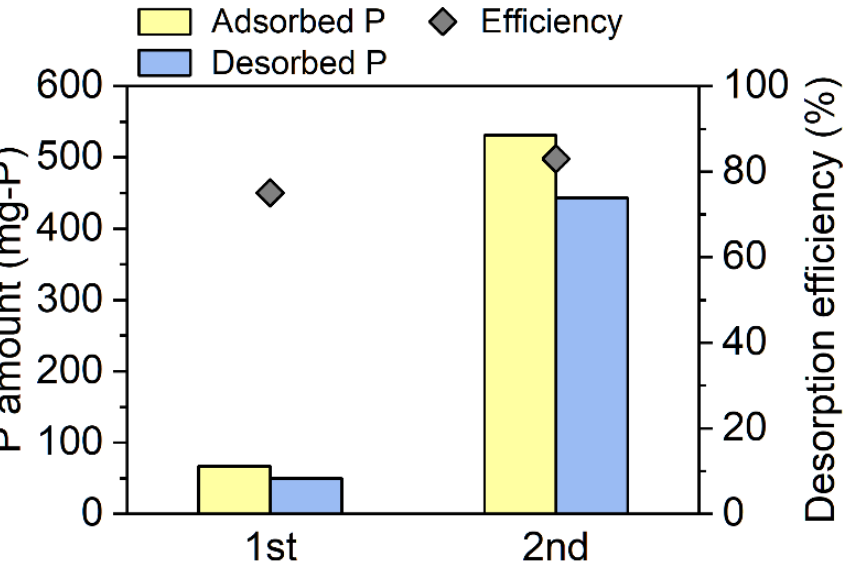
Figure 3. Amounts of phosphorus adsorbed on the adsorbent in the column during phase 2 and phases 3–4 as well as the amounts of phosphorus desorbed from the adsorbent. The diamonds indicate the phosphorus desorption efficiency.